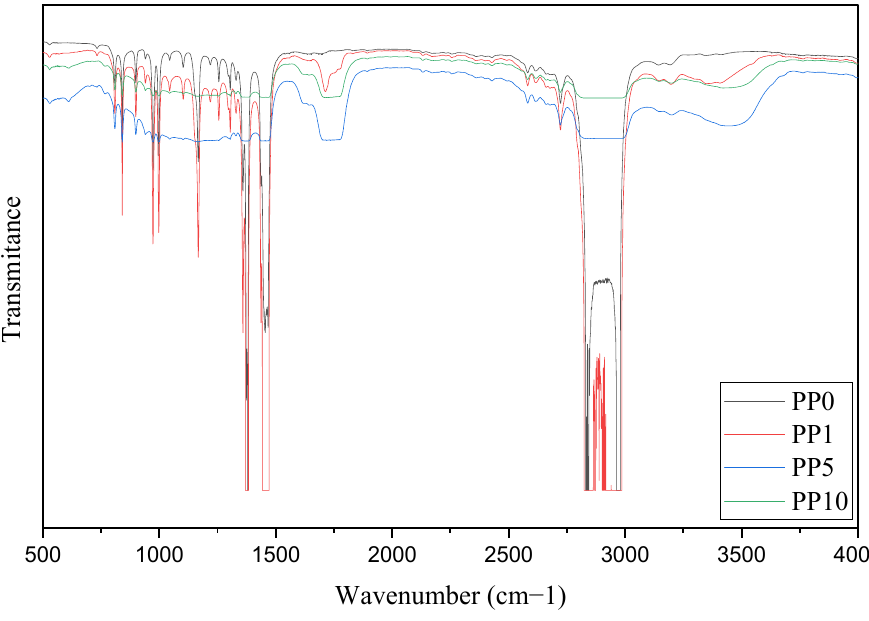
Figure 7. Carbonyl index of PP samples.